Question: Condense the content of this figure into a single sentence.
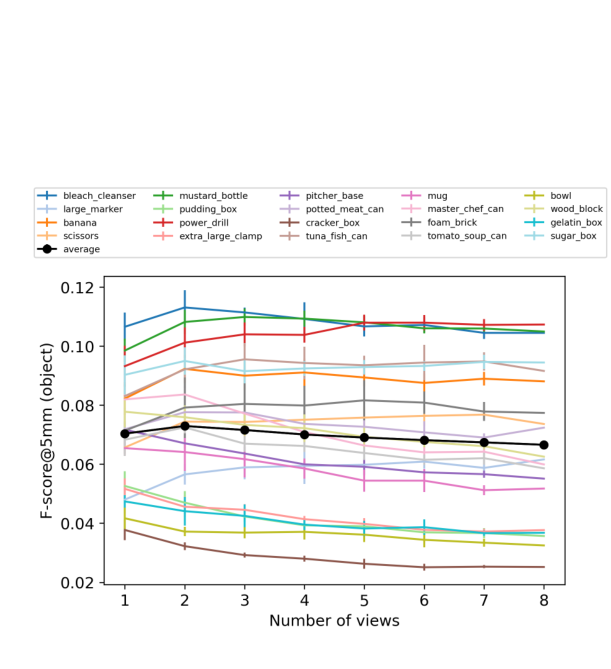
Answer: Average F-score across 6 runs per object when varying the number of input views